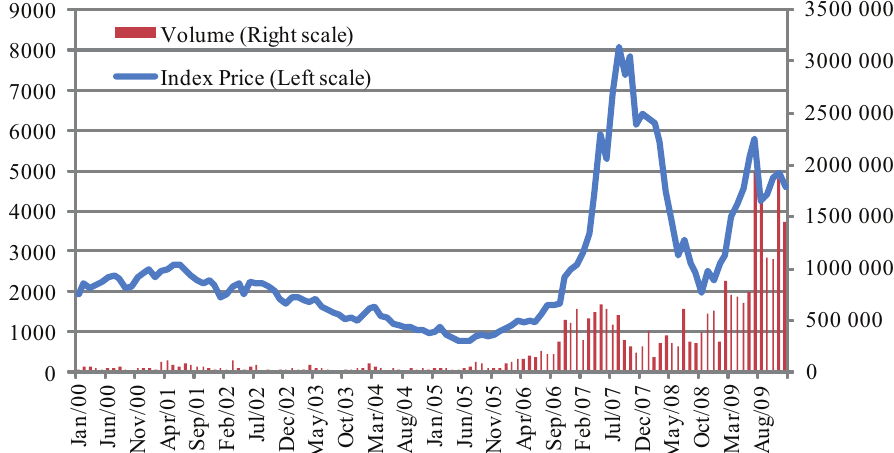
figure 1. Historical China property security composite index: Jan, 2000 to Dec, 2009. Source: